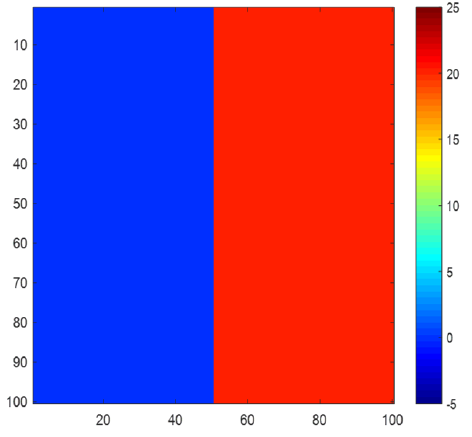
Figure 12. Height of simulated area.